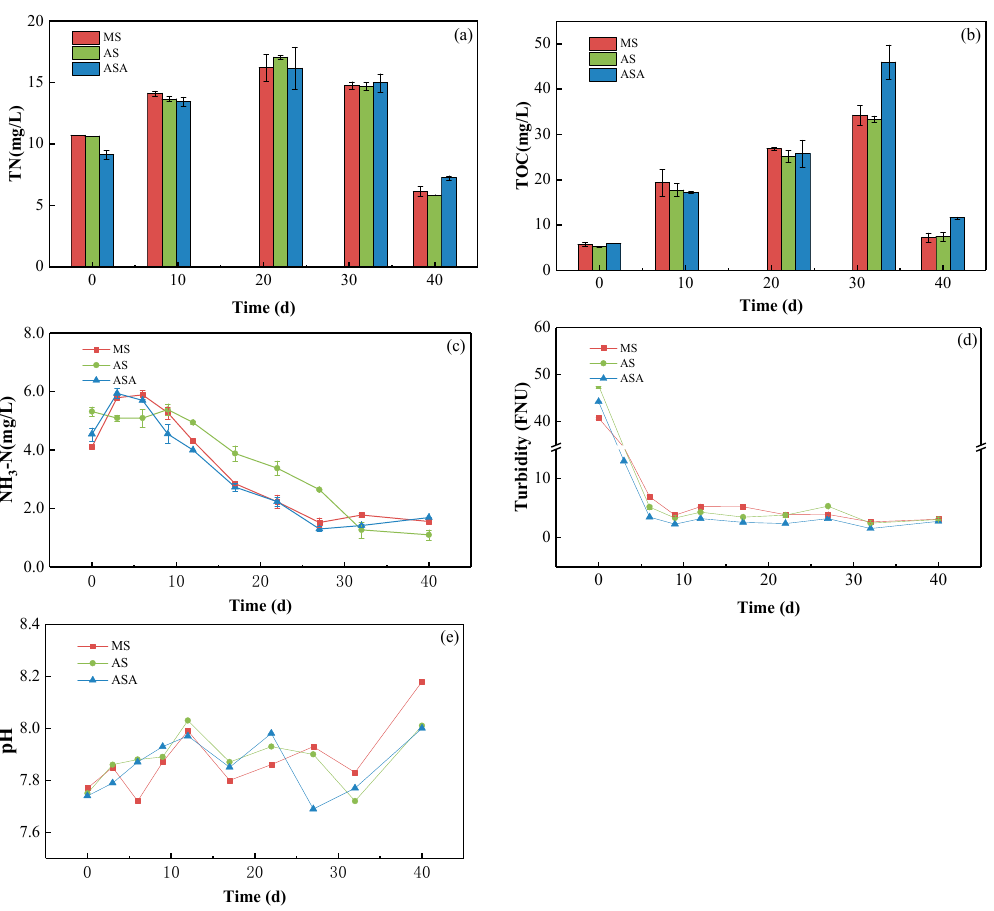
Figure 7. Changes in water quality parameters in MS, AS and ASA groups.